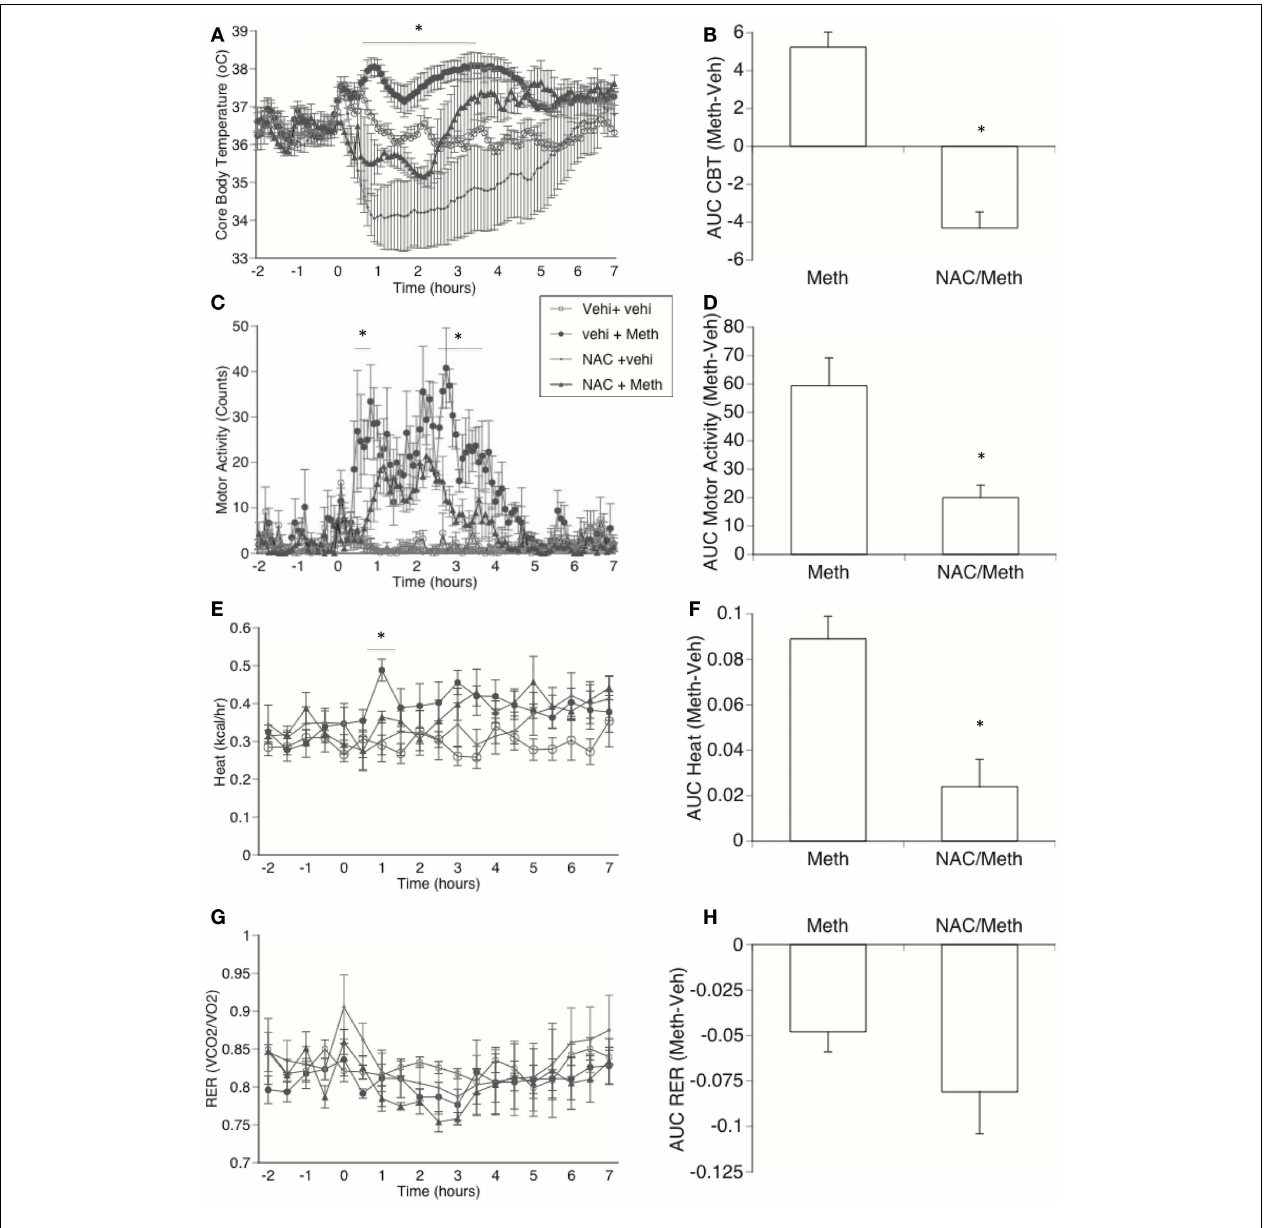
t -test. Area under the curve (AUC) was used to quantify changes in (B) CBT, (D) locomotor activity, (F) heat, and (H) RER in Meth compared to vehicle-injected animals, and to investigate the effect of NAC.Values represent the average difference between Meth-injected and Vehicle-injected respective controls ± SEM, for four animals/group. * p < 0.05, ANOVA followed by Bonferroni’s post hoc test, n = 4